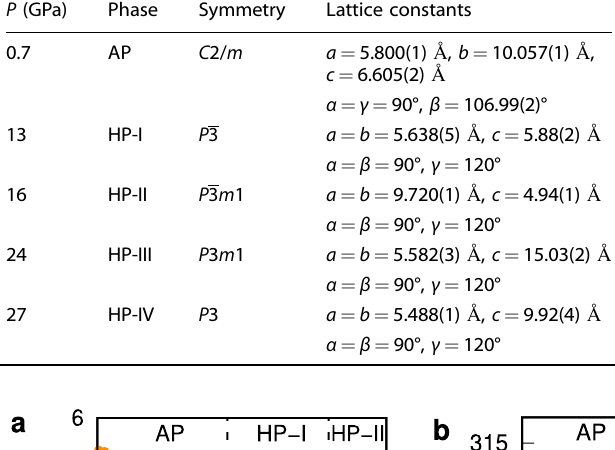
Table 1. Symmetry and lattice constants for the ambient pressure (AP) and high-pressure (HP) phases of NiPS 3 . P